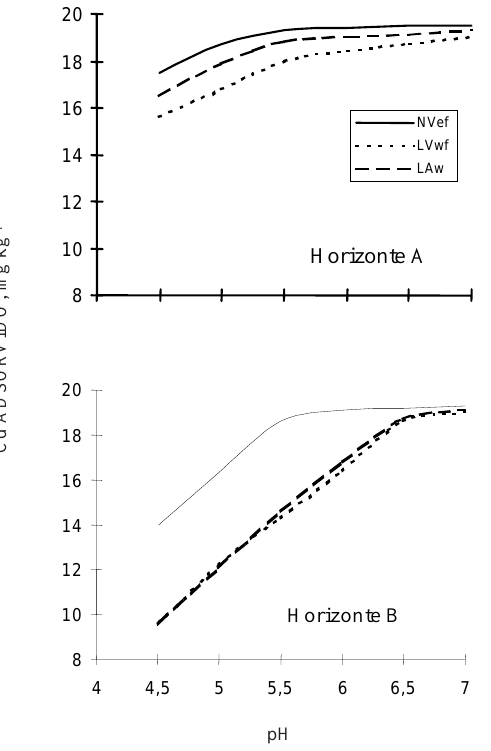
Figura 1. Efeito do pH sobre a adsorção de cádmio nos horizontes A e B dos solos estudados (NVef = Nitossolo Vermelho eutroférrico; LVwf = Latossolo Vermelho acriférrico; Law = Latossolo Amarelo